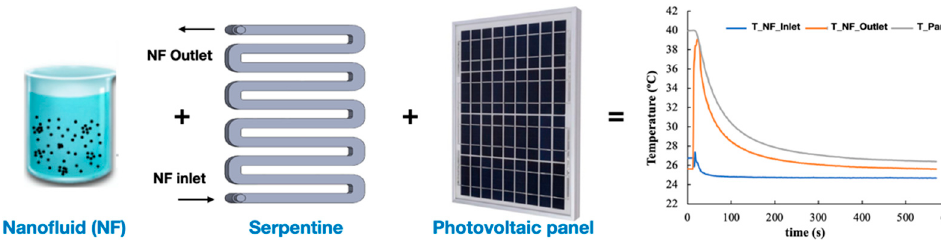
Figure 3. Scheme illustrating the use of nanofluids in serpentines for cooling photovoltaic solar pan-